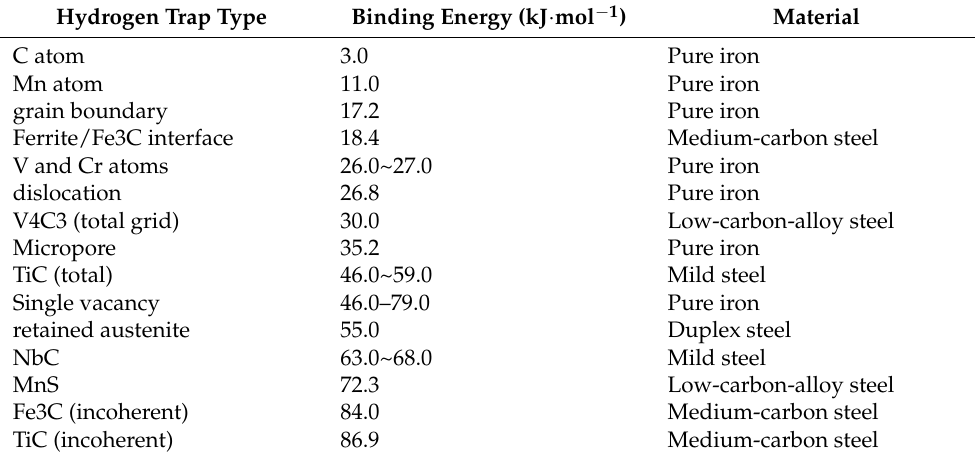
Table 3. Binding energy of different hydrogen traps